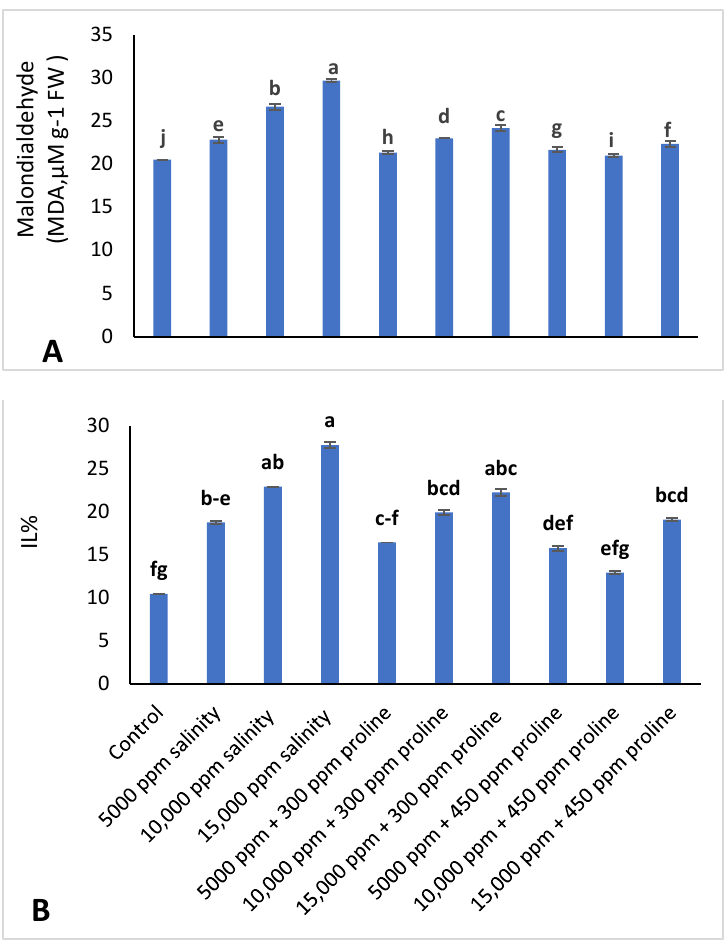
Figure 6. Effect of different levels of seawater salinity and exogenous proline at three concentrations, 0 ppm, 300 ppm, and 450 ppm, on MDA ( μ M g − 1 FW) ( A ) and IL (%) ( B ). Data are means of two seasons (2020 and 2021) and three replicates ( n = 3) each season. The mean values ± SE of each parameter followed by different alphabetical letters are significantly different according to Duncan’s multiple range test at p ≤ 0.05.